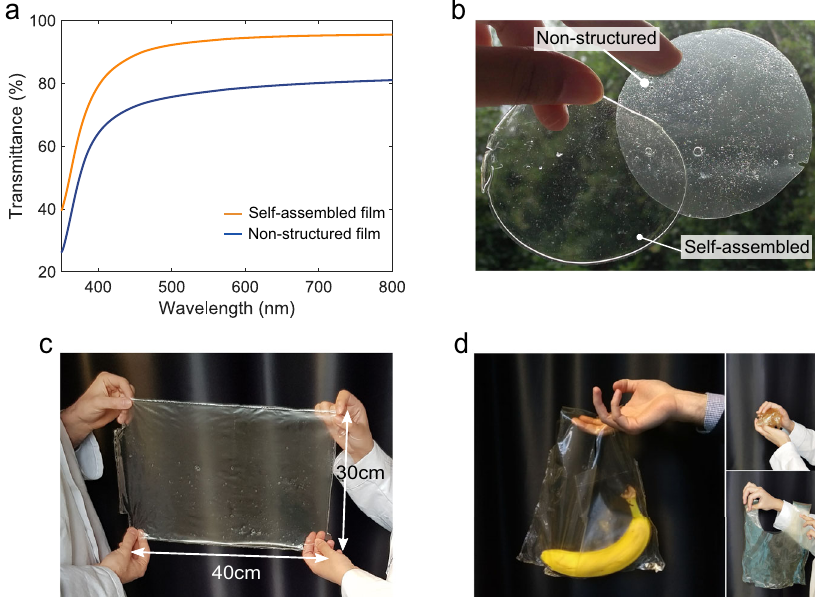
Fig. 5 Optical appearance of self-assembled fi lms. a UV – vis spectra of nonstructured (blue) and self-assembled fi lms (orange). b Optical image of nonstructured (right) and self-assembled (left) SPI fi lms. c Photograph of a 30 × 40 cm fi lm fabricated through large-scale processing. d Carrying bag generated by thermal